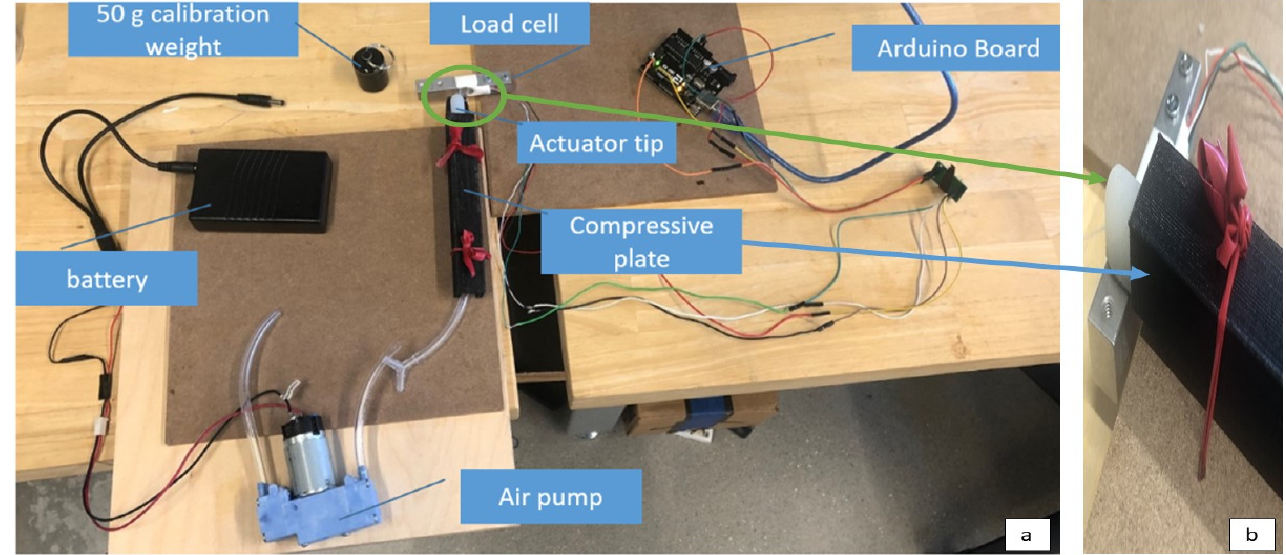
Figure 5. Apparatus showing the experimental set up of blocked tip force measurements using load cell ( a ) and close up of the blocked tip force apparatus ( b